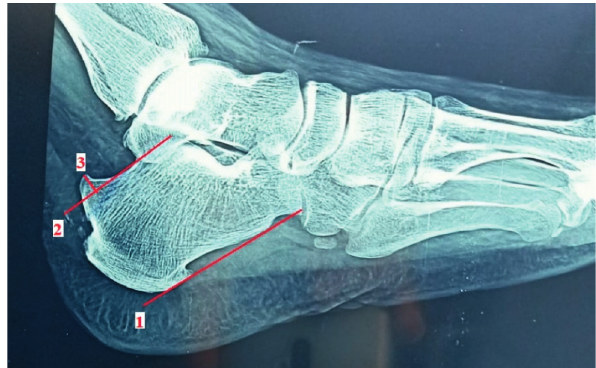
Figure 1: Length of bony exostosis is measured on lateral X-ray view of the calcaneus. Line 1 starts from the most inferior point of the calcaneocuboid along the plantar aspect of the calcaneus. Line 2 extends from the highest point of the subtalar and is parallel to line 1. Line 3 indicates the length of the bony hump above line 2.